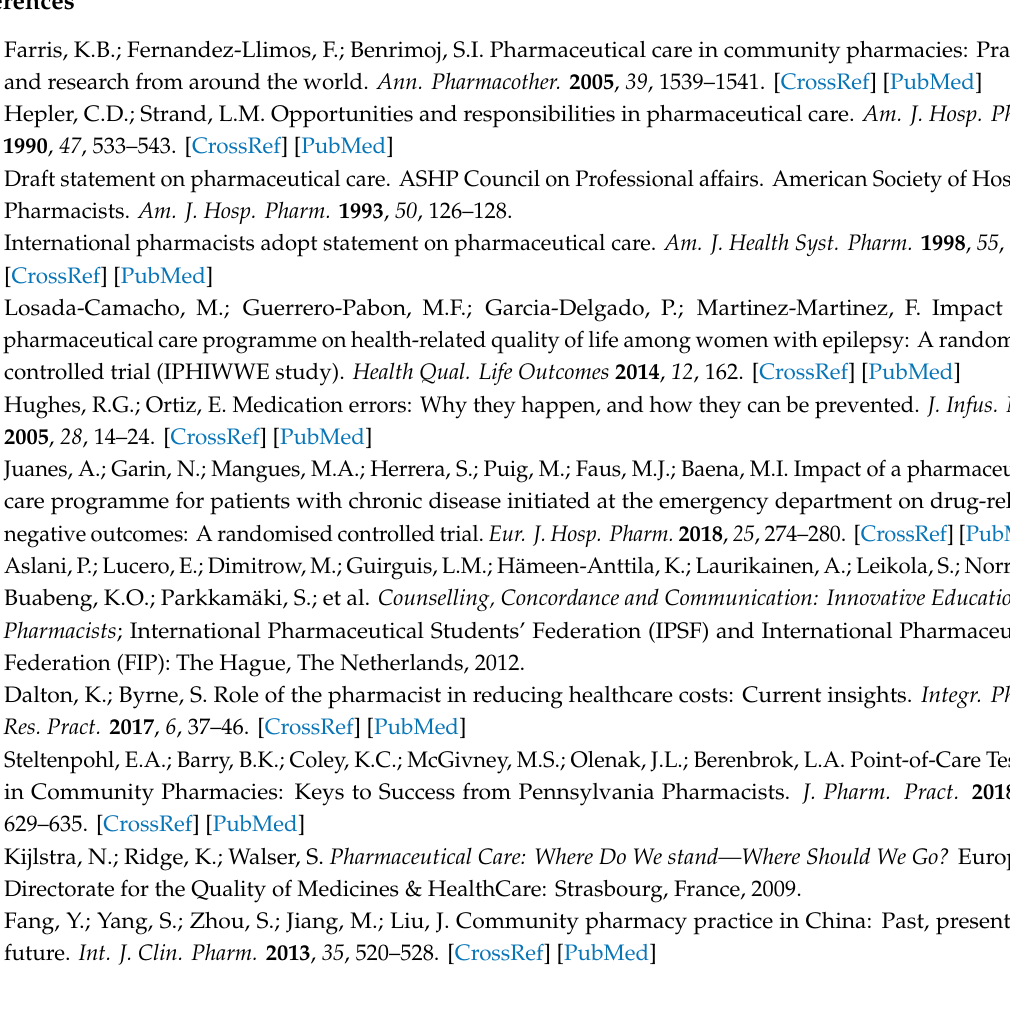
Figure S1: Questionnaire, Figure S2: Post hoc